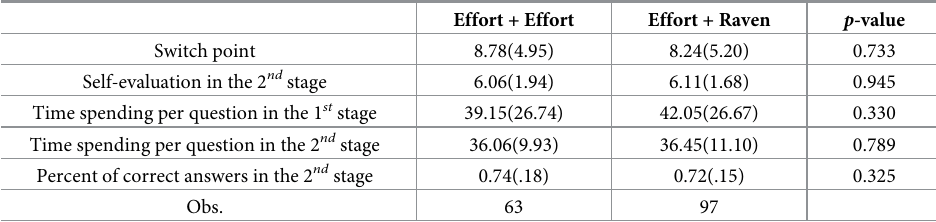
Table 3. Task type combination comparison.